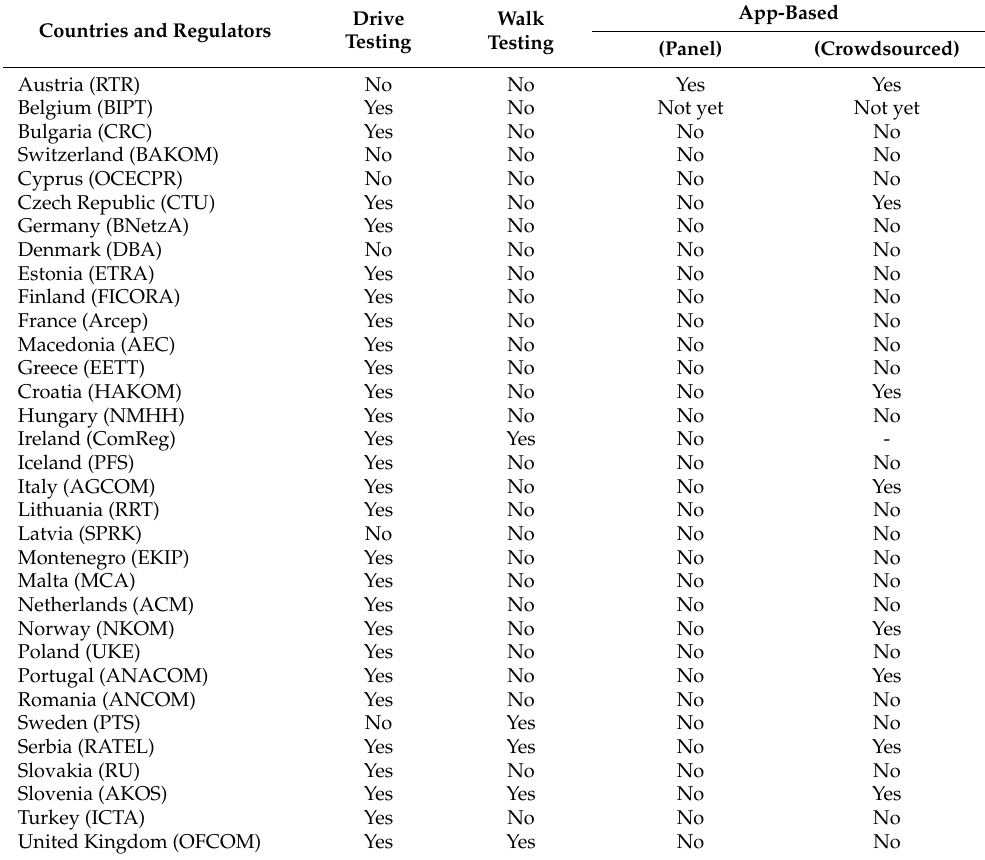
Table 7. Different methodologies adopted for BEREC